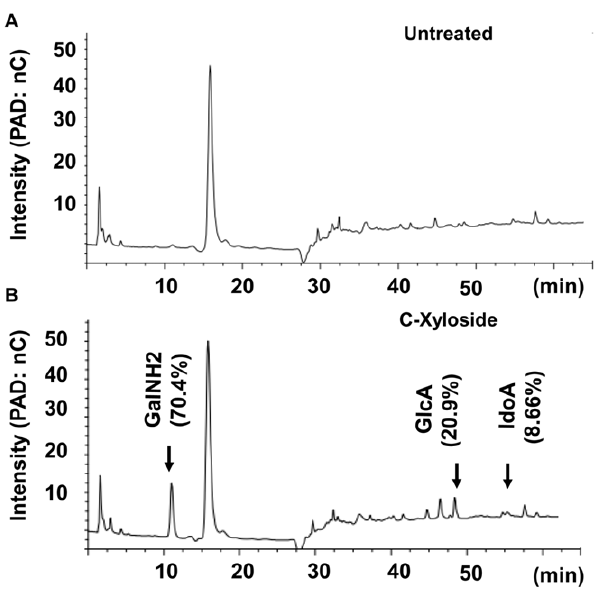
Figure 2. Monosaccharide composition analysis of GAGs release by NHEKs. Media were harvested after 24 hours of culture (A) without or (B) with C-Xyloside (1 mM) stimulation and monosac- charide compositions were analyzed by HPAEC chromatograph as described under ‘materials and methods’. The peak at 17 min may represent a monosaccharide such as glucose in the media (Glc). Arrows indicate the retention time for galactosamine (GalNH2), glucuronic acid (GlcA), and iduronic acid (IdoA). PAD: pulsed amperometric detection; nC: nano-coulomb. Data are representative of three individual